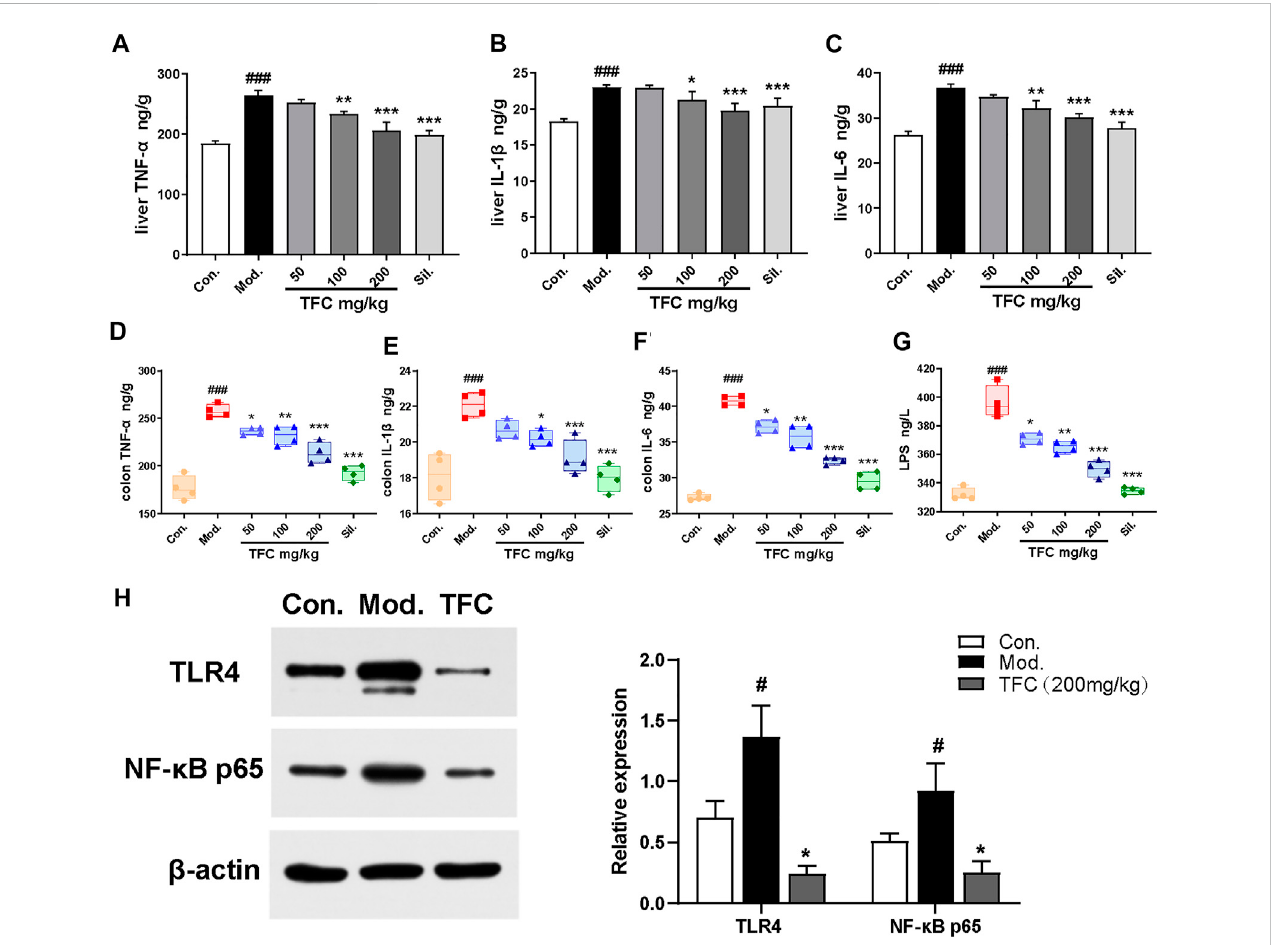
FIGURE 6 TFC ameliorates alcohol -induced hepatic-intestinal in fl ammatory response via the TLR4/NF- κ B pathway (A) Level of TNF- α in liver (B) level of IL-1 β in liver (C) level of IL-6 in liver (D) level of TNF- α in colon (E) level of IL-1 β in colon (F) level of IL-6 in colon (G) level of LPS in serum (H) the expression levels of TLR4andNF- κ Bp65weredetectedbywesternblotanalysis.Dataareexpressedasmean±S.D. # p < 0.05, ## p < 0.01, ### p < 0.001vs.controlgroup;* p < 0.05, **p < 0.001, ***p < 0.001vs. model